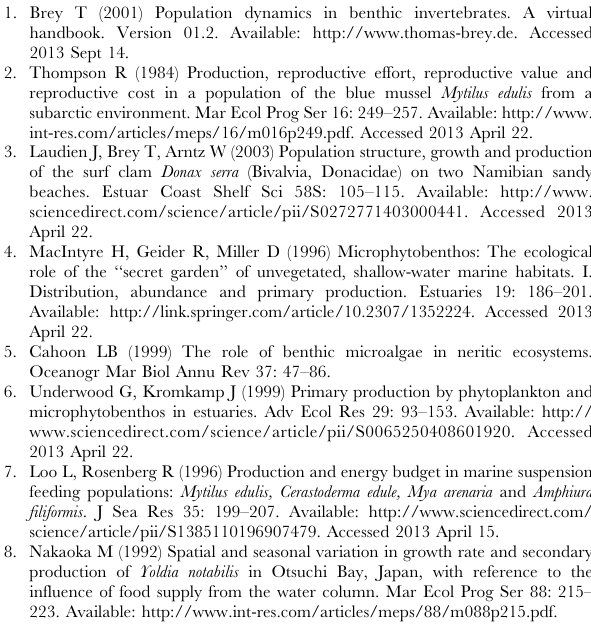
Figure S1 Seasonal variations of macro-benthic bio- mass (in kgWW m –2 ) at each tidal flat station. (TIF)